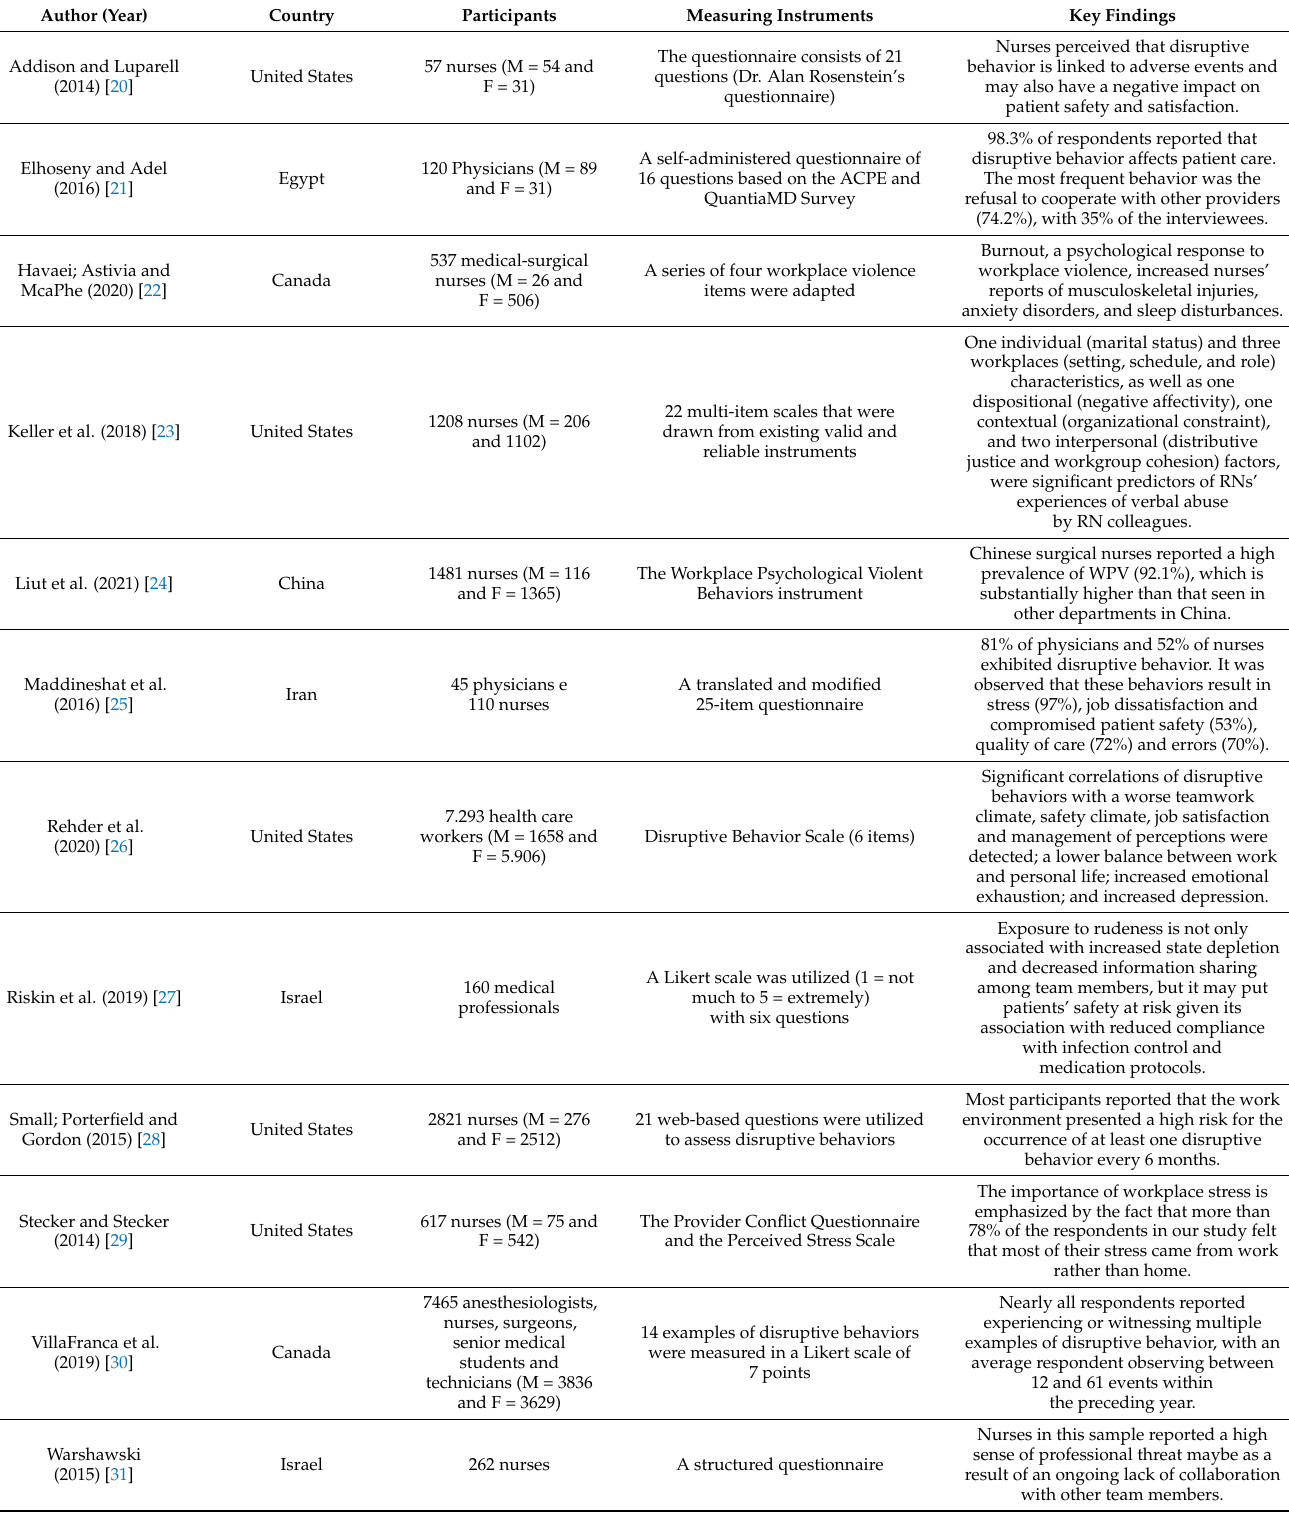
Table 1. Characteristics of the studies included in the systematic